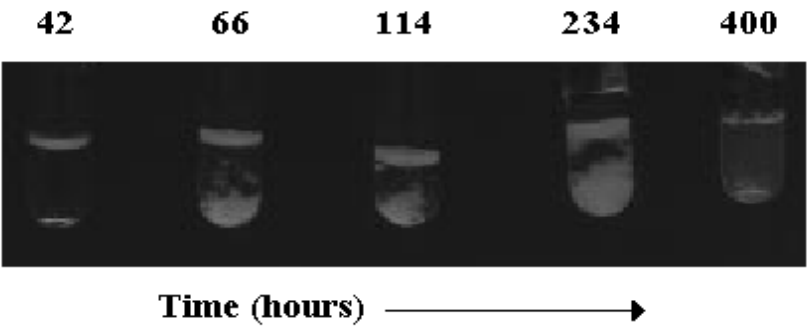
Figure 5. Phase evolution with time, in hours, in a solution containing 41.5 wt% sodium taurodeoxycholate, NaTDC , viewed between crossed polarisers. The solution was formerly heated and equilibrated at 25.0 °C. Note the presence of an upper anisotropic layer, changing its thickness and consistency with time (lanes 2-4), the formation of small crystals in the bottom (lanes 2 and 3), creaming (lane 4), and formation of a birefringent, liquid crystal (lane 5).